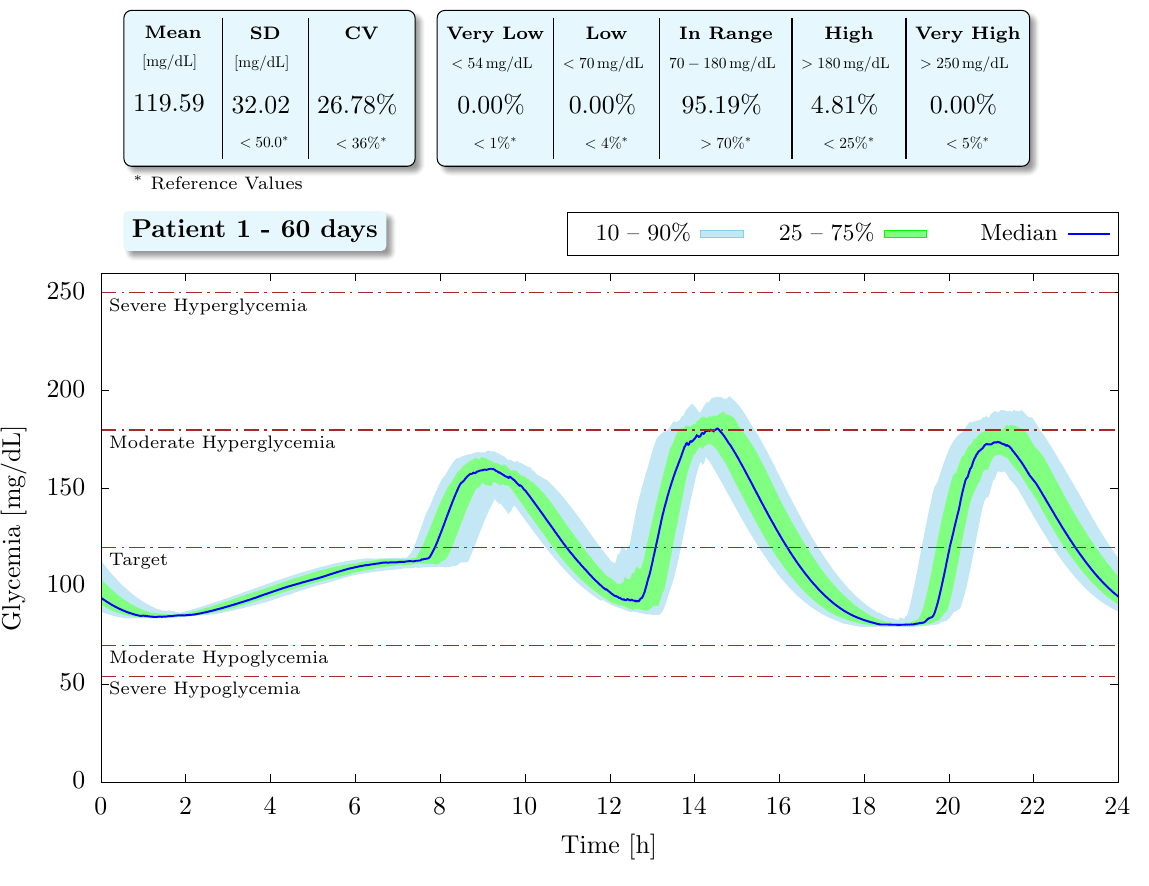
Figure 7. Glycemic profile of patient 1 with median and interpercentile